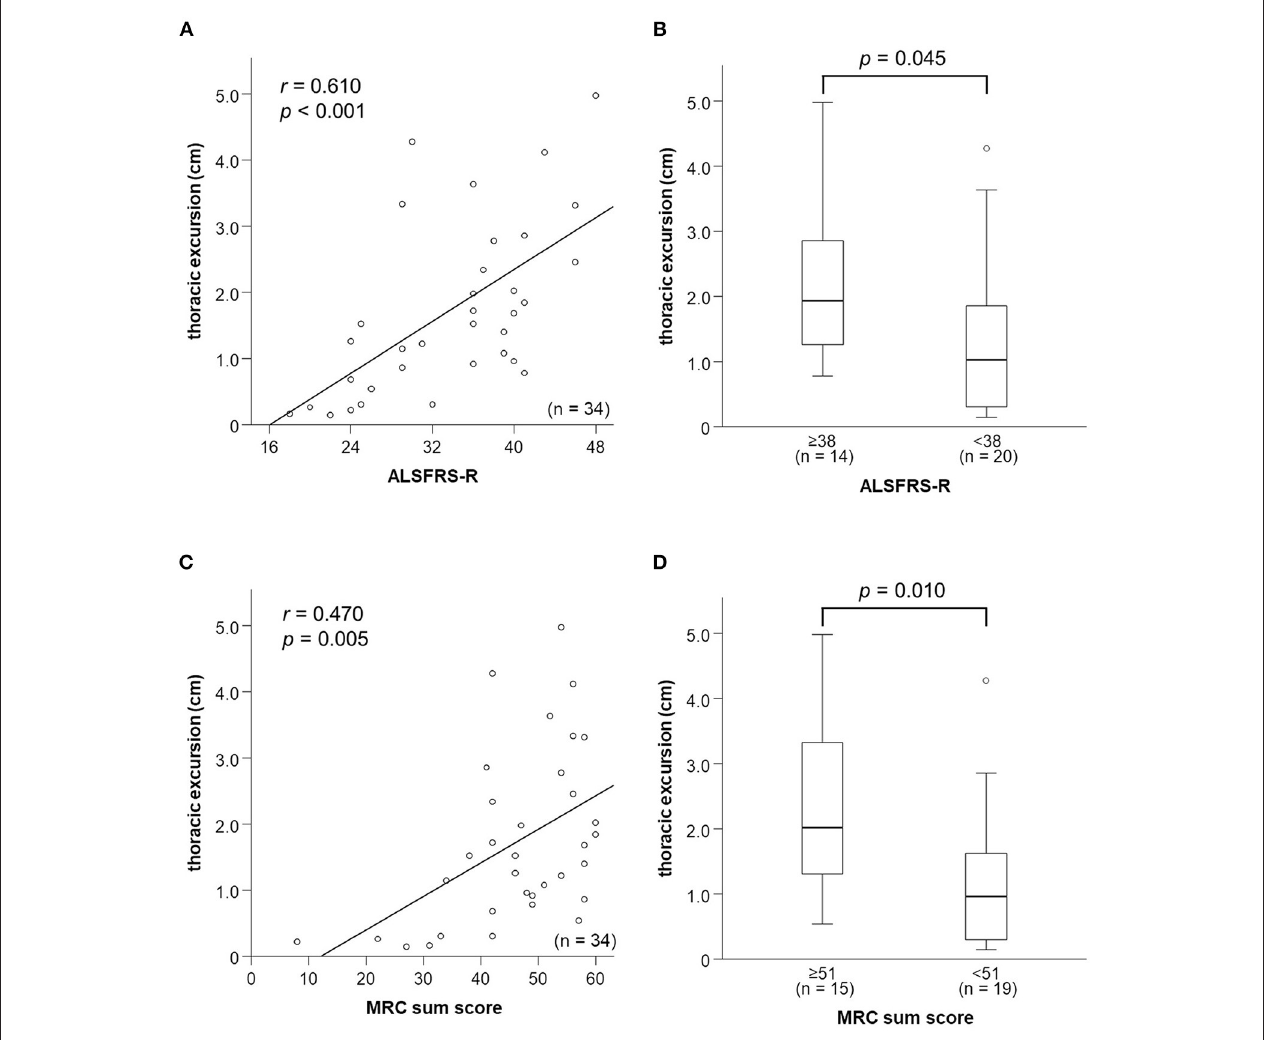
FIGURE 4 | Relationships between respiratory function parameters and general condition. (A) Relationship between thoracic excursion and ALSFRS-R score. Thoracic excursion is strongly correlated with ALSFRS-R score. (B) Thoracic excursion is significantly lower in the patients in the mild respiratory dysfunction group whose ALSFRS-R score is < 38 than those whose ALSFRS-R score is not < 38. (C) Relationship between thoracic excursion and MRC sum score. Thoracic excursion is strongly correlated with MRC sum score. (D) Thoracic excursion is significantly lower in patients in the mild respiratory dysfunction group whose MRC sum score